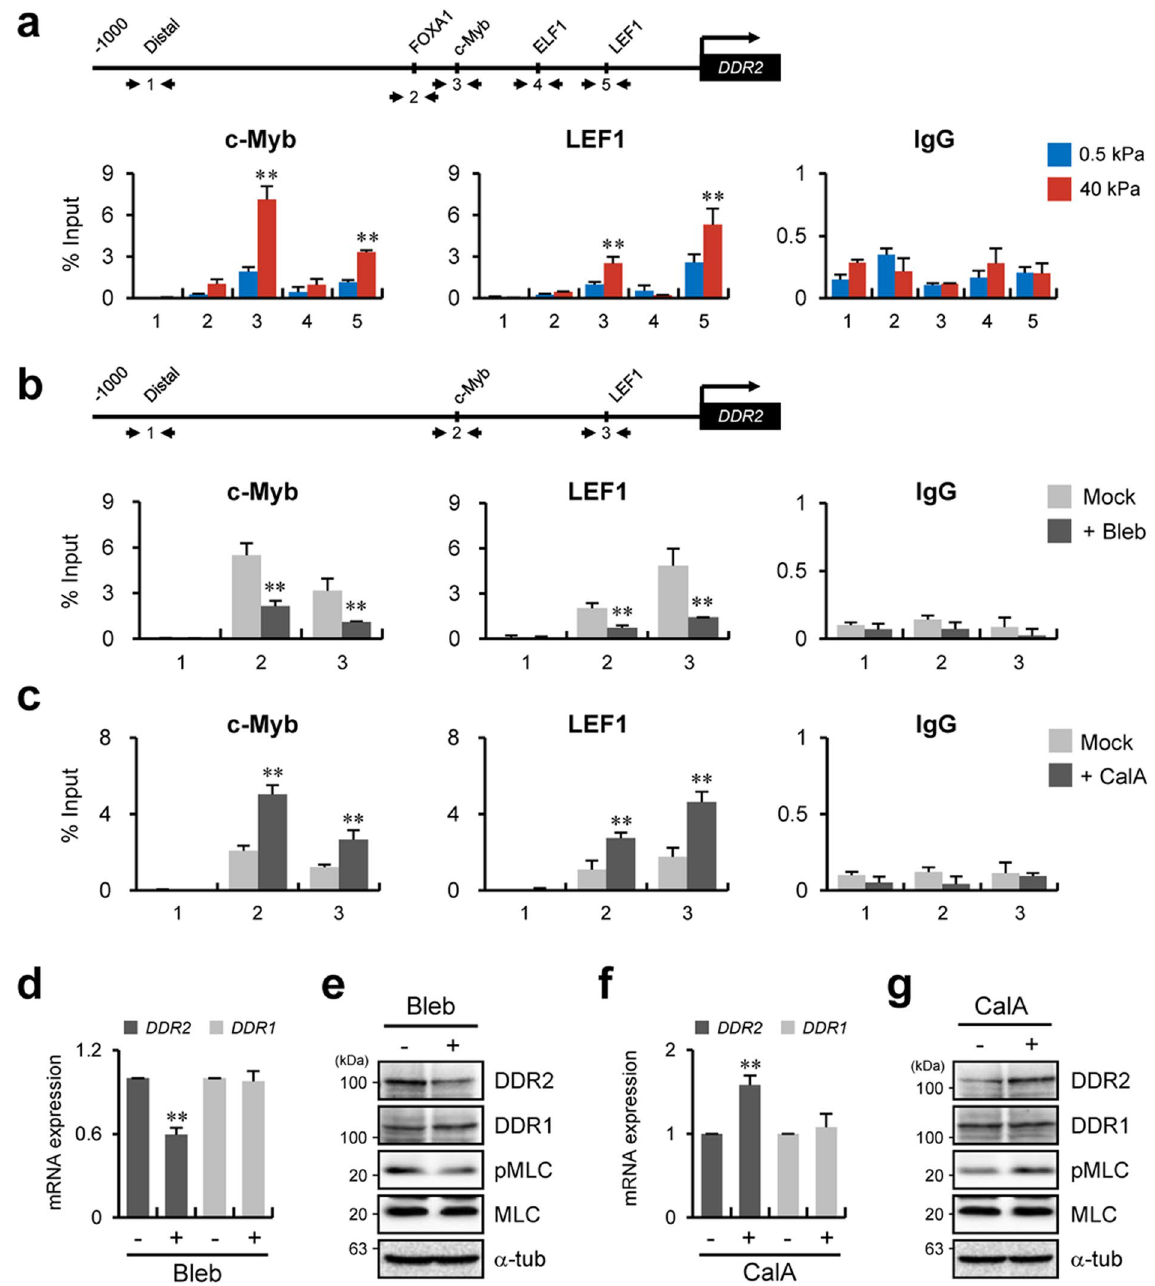
Figure 4. Increased cellular contractility on a stiff matrix is responsible for recruitment of c-Myb and LEF1 to the DDR2 promoter. ( a ) Schematic depiction of the DDR2 WT promoter with distal and putative binding sites for FOXA1, c-Myb, ELF1, and LEF1. Primer sets for chromatin immunoprecipitation (ChIP) analysis are indicated by the arrows in the scheme (top). ChIP analysis of the binding of c-Myb and LEF1 to the DDR2 WT promoter in H1299 cells under the indicated conditions. qRT-PCR analysis with primers specific to one of five regions in the DDR2 WT promoter as indicated in the scheme (bottom). ( b , d , e ) ChIP analysis of the binding of c-Myb and LEF1 to the DDR2 WT promoter in H1299 cells in the absence or presence of 10 μ M blebbistatin on a PAG with 40-kPa stiffness ( b ). qRT-PCR analysis of DDR1 and DDR2 ( d ) and western blot analysis of DDR1, DDR2, MLC, and pMLC (e) under the same conditions as in panel b. ( c , f , g ) ChIP analysis of the binding of c-Myb and LEF1 to the DDR2 WT promoter in H1299 cells in the absence or presence of 2.5 nM calyculin A on a PAG with 0.5-kPa stiffness ( c ). qRT-PCR analysis of DDR1 and DDR2 ( f ) and western blot analysis of DDR1, DDR2, MLC, and pMLC ( g ) under the same conditions as in panel c. All data represent the mean of three independent experiments ± SEM. ** P <